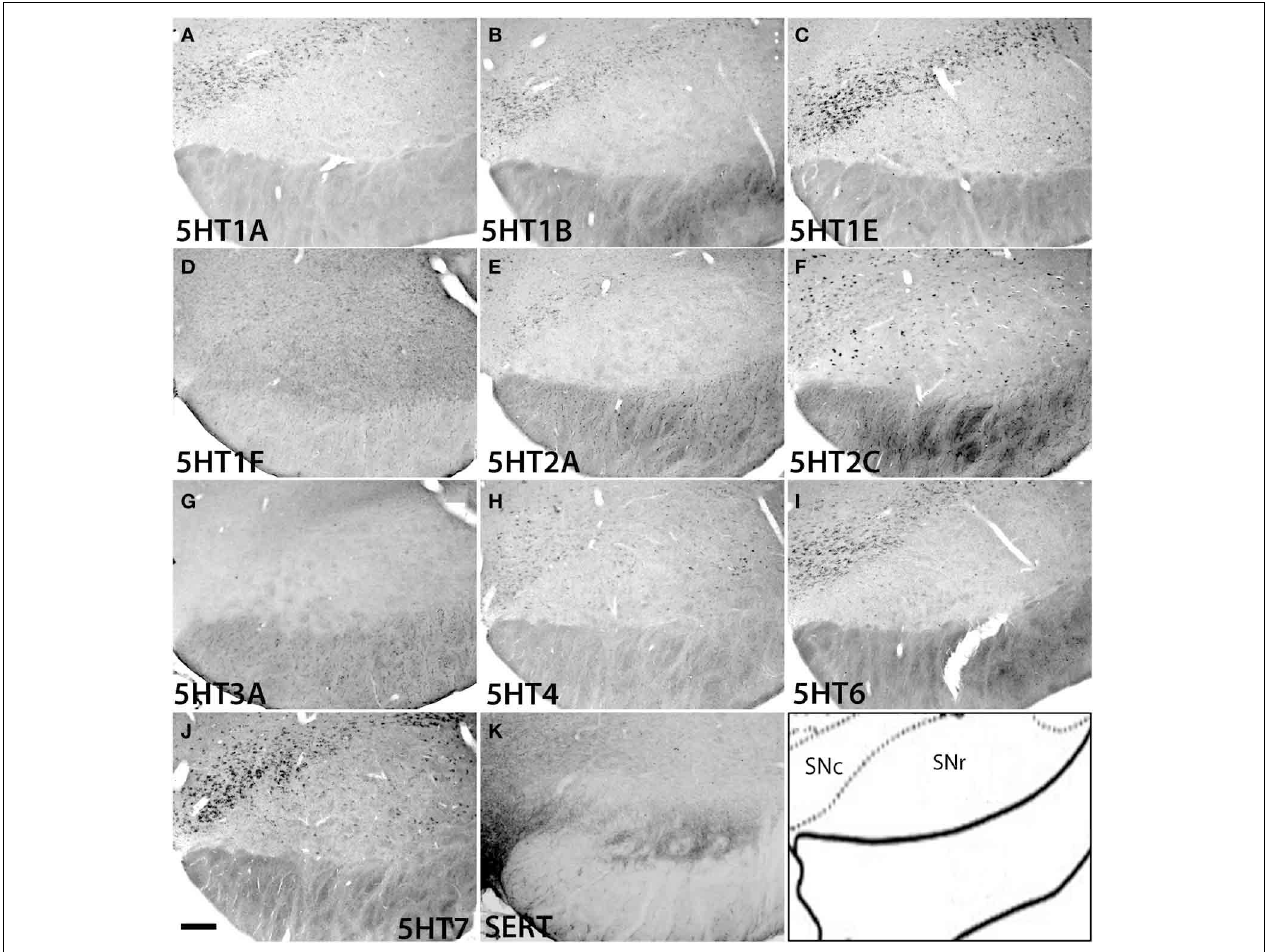
FIGURE 13 | ISH expression profiles of 5HTR s in substantia nigra. 5HTR mRNA expressions (A–J) and immunohistochemical staining with anti-SERT antibody (K) in pars compact (SNc) and